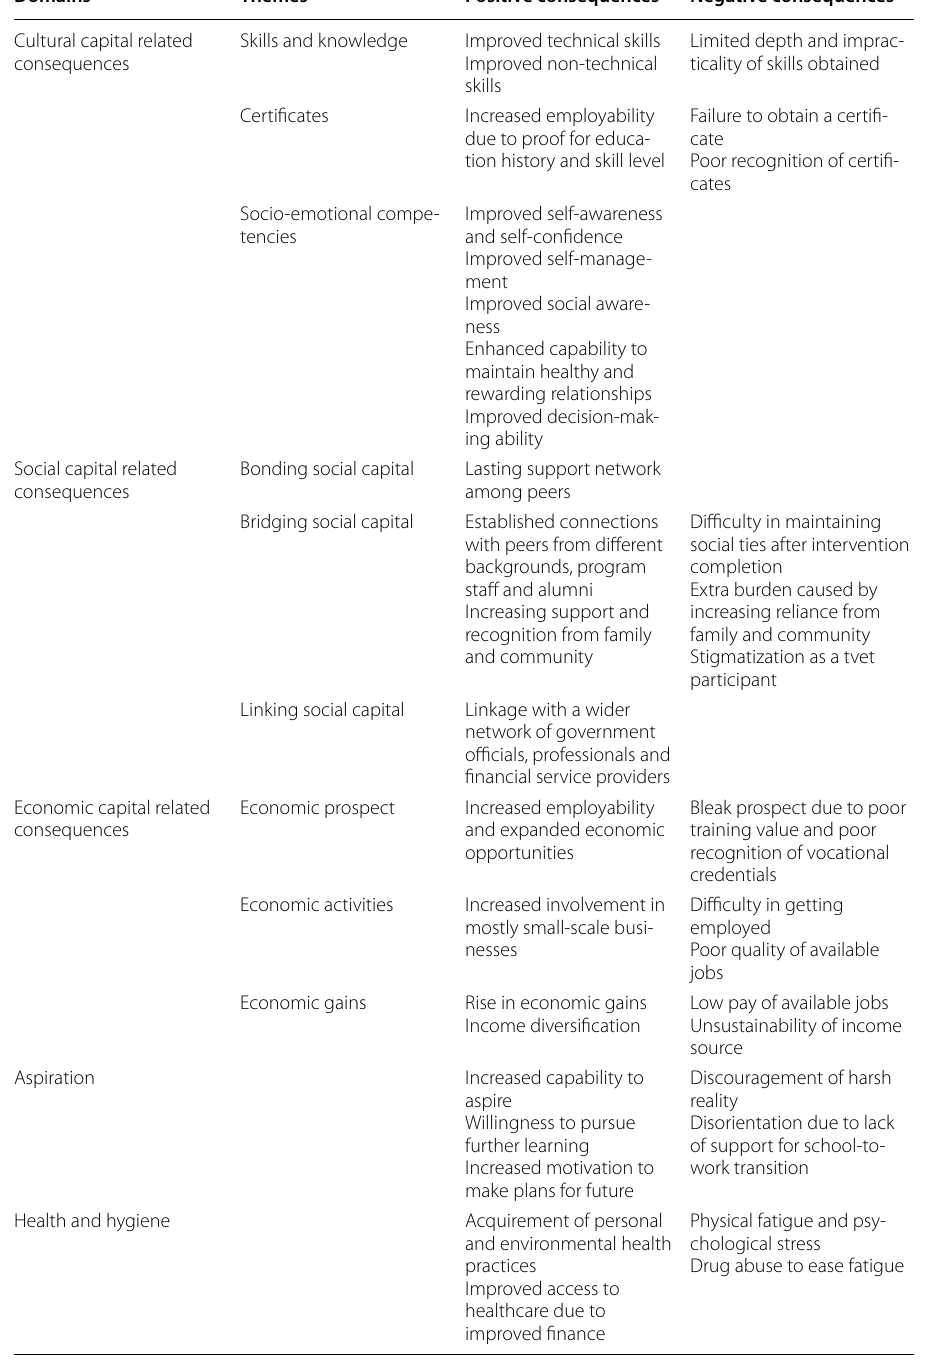
Table 4 A Summary of Young People’s Participation